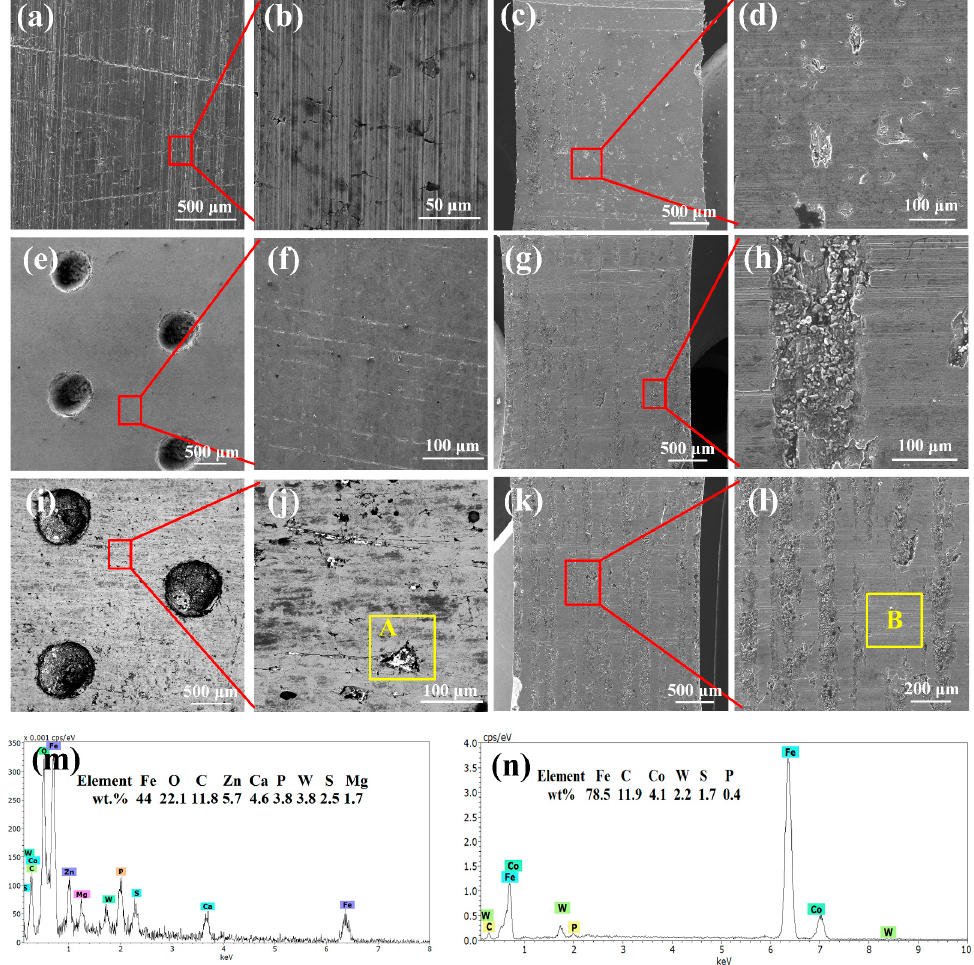
Figure 5. Morphology and EDS result of different samples after testing at high temperature; ( a , b ) the surface morphologies of the OC sample, ( c , d ) the surface morphologies of the piston ring corresponding to OC sample, ( e , f ) the surface morphologies of the TC sample, ( g , h ) the surface morphologies of the piston ring corresponding to TC sample, ( i , j ) the surface morphologies of the TCW sample, ( k , l ) the surface morphologies of the piston ring corresponding to TCW sample, ( m ) the EDS result of area A, ( n ) the EDS result of area B.